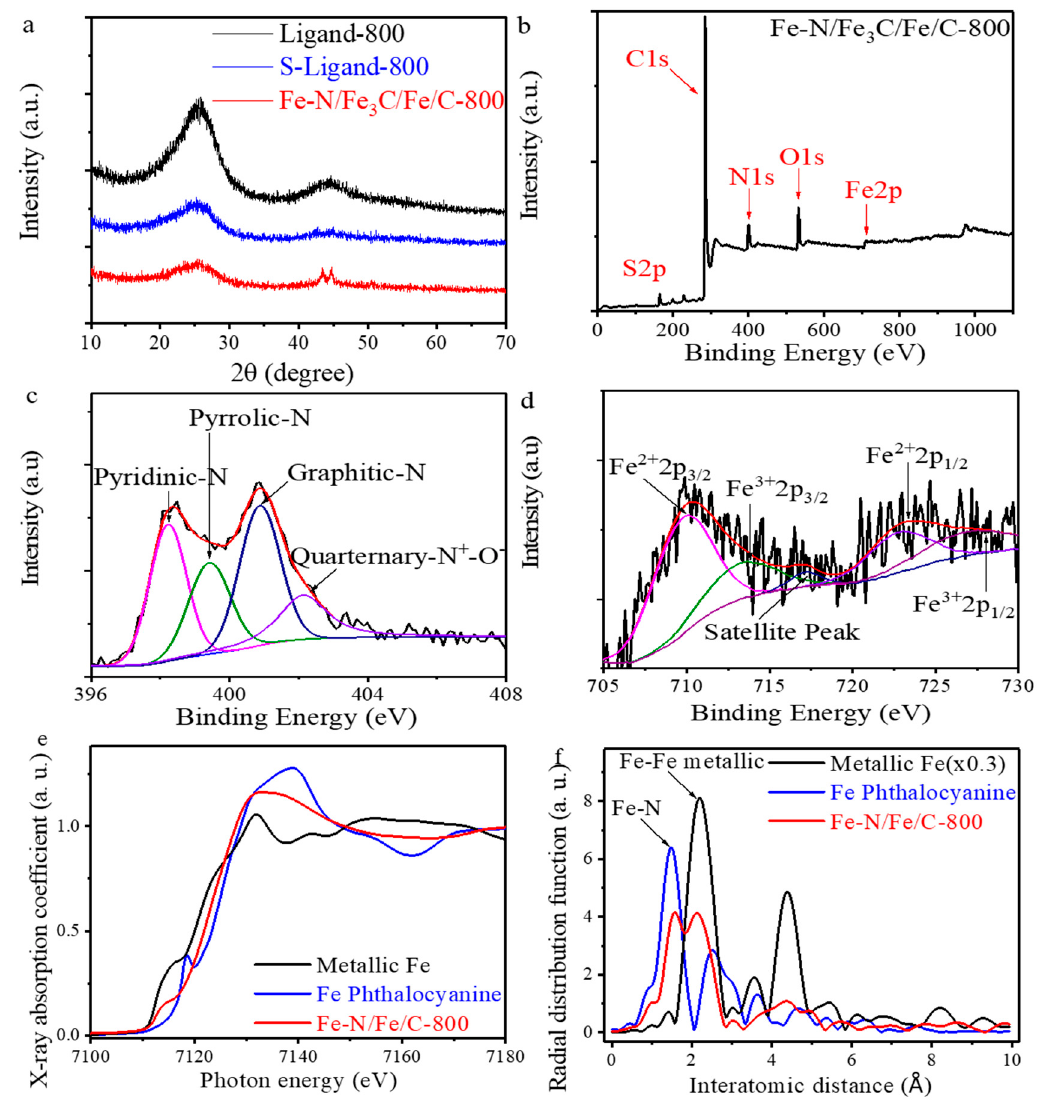
Figure 2. ( a ) XRD spectra of Ligand-800, S-Ligand-800 and Fe-N/Fe 3 C/Fe/C-800; ( b ) full XPS spectrum of Fe-N/Fe 3 C/Fe/C-800; ( c ) XPS spectra of Fe2p for Fe-N/Fe 3 C/Fe/C-800 in the range of 705 to 730 eV; ( d ) XPS spectra of N1s for Fe-N/Fe 3 C/Fe/C-800; ( e ) XANES spectra for Fe K-edge of Fe-N/Fe 3 C/Fe/C-800 and references; and ( f ) EXAFS spectra for Fe K-edge of Fe-N/Fe 3 C/Fe/C-800 and references.